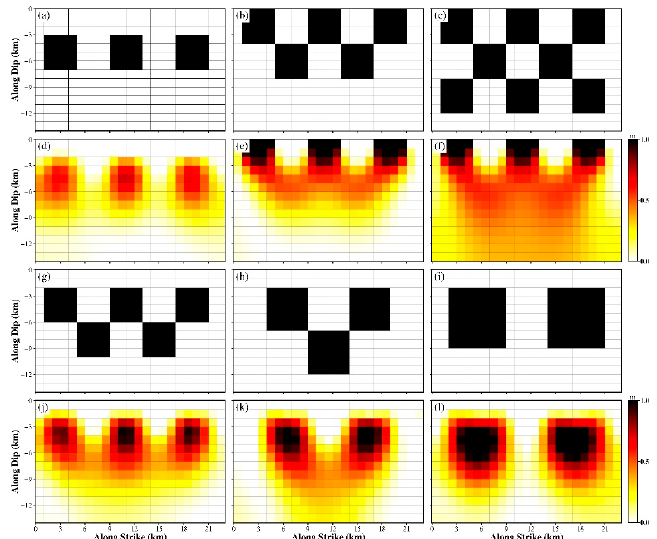
Figure 11. Checkerboard test results for joint inversion model based on different input models. ( a – c ) and ( g – i ) 4 × 4, 5 × 5, 7 × 7 sub-patches for each concave-convex body in the six input models, respectively. ( d – f ) and ( j – l ) are the corresponding joint LOS and BOI-derived azimuth displacements inversions of the slip distributions.